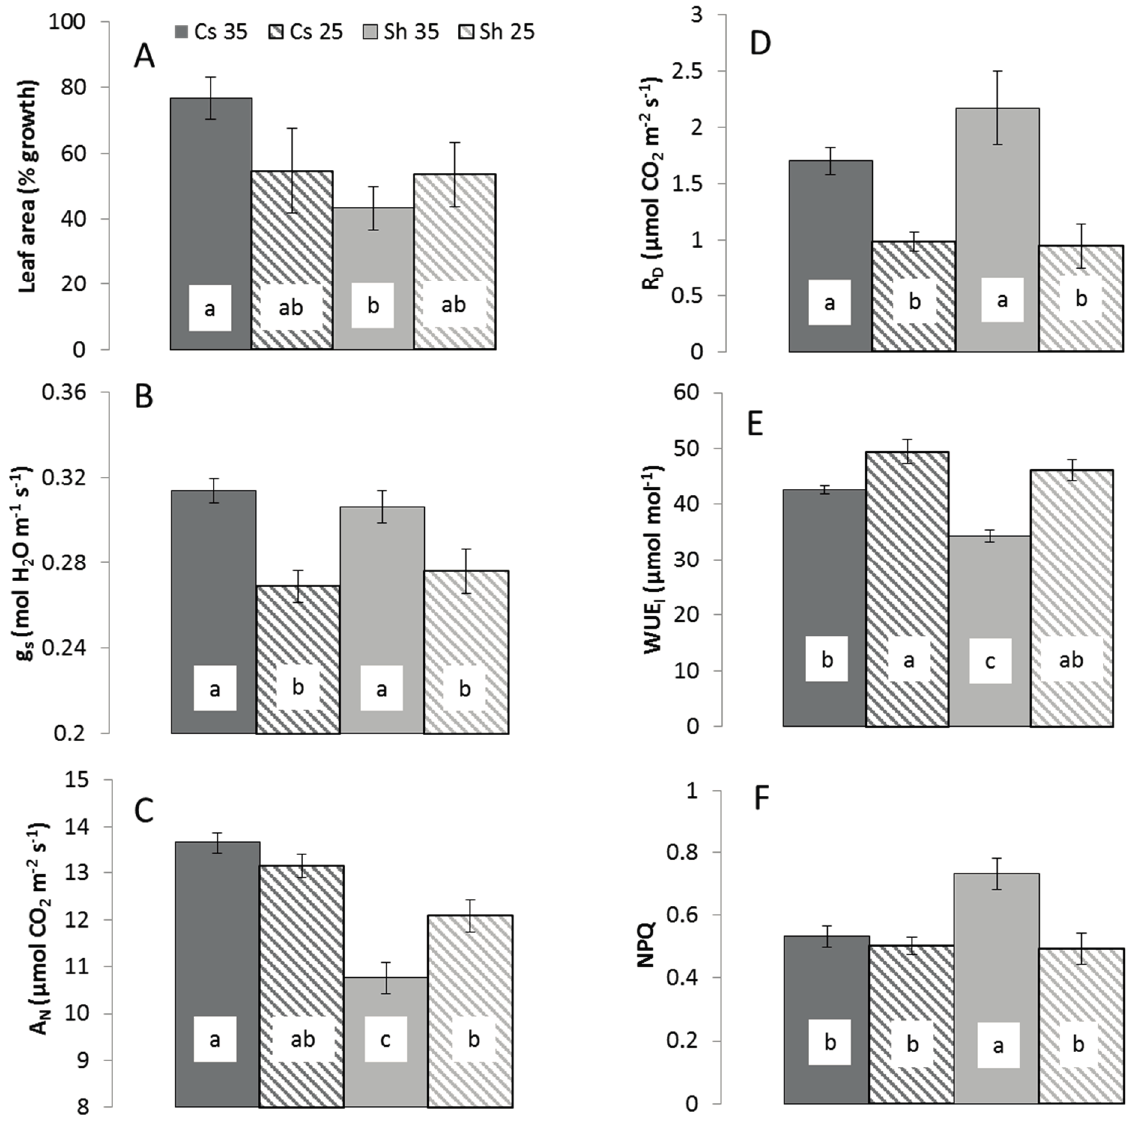
Figure 1. Leaf area growth as a percent of the leaf area in day 1 ( A ) Stomata conductance ( g s ; ( B )) net assimilation ( A N ; ( C )) dark respiration ( R D ; ( D )) intrinsic water use efficiency (WUEi, ( E )), and non-photochemical quenching (NPQ; ( F )) of Shiraz and Cs on the 25 and 35 °C treatment. Data are means ± S.D of all measuring days of the two experiments. n = 8. Different letters represent significant difference between